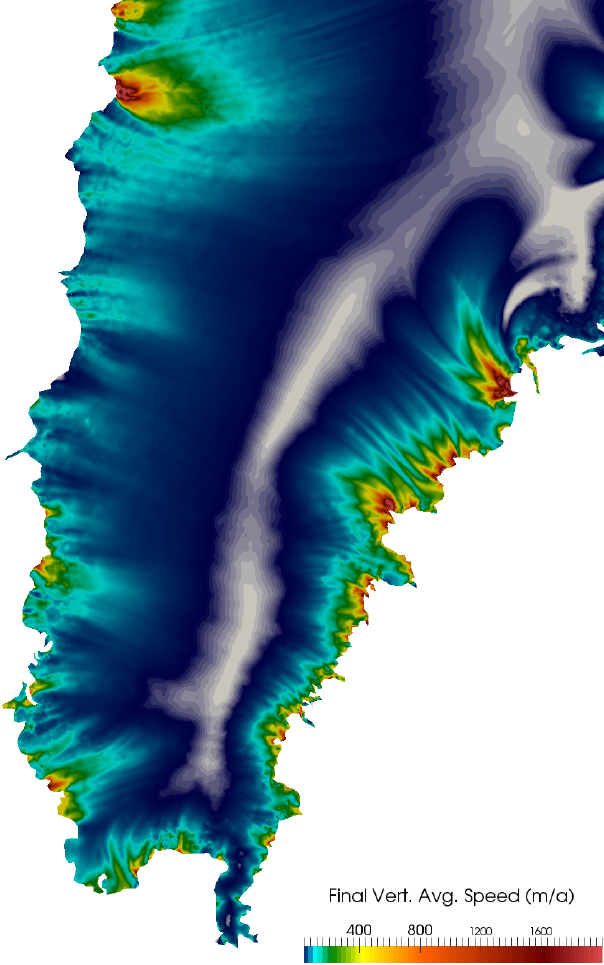
Figure 3. Surface speed of ice from observations reported in Joughin et al. (2010).